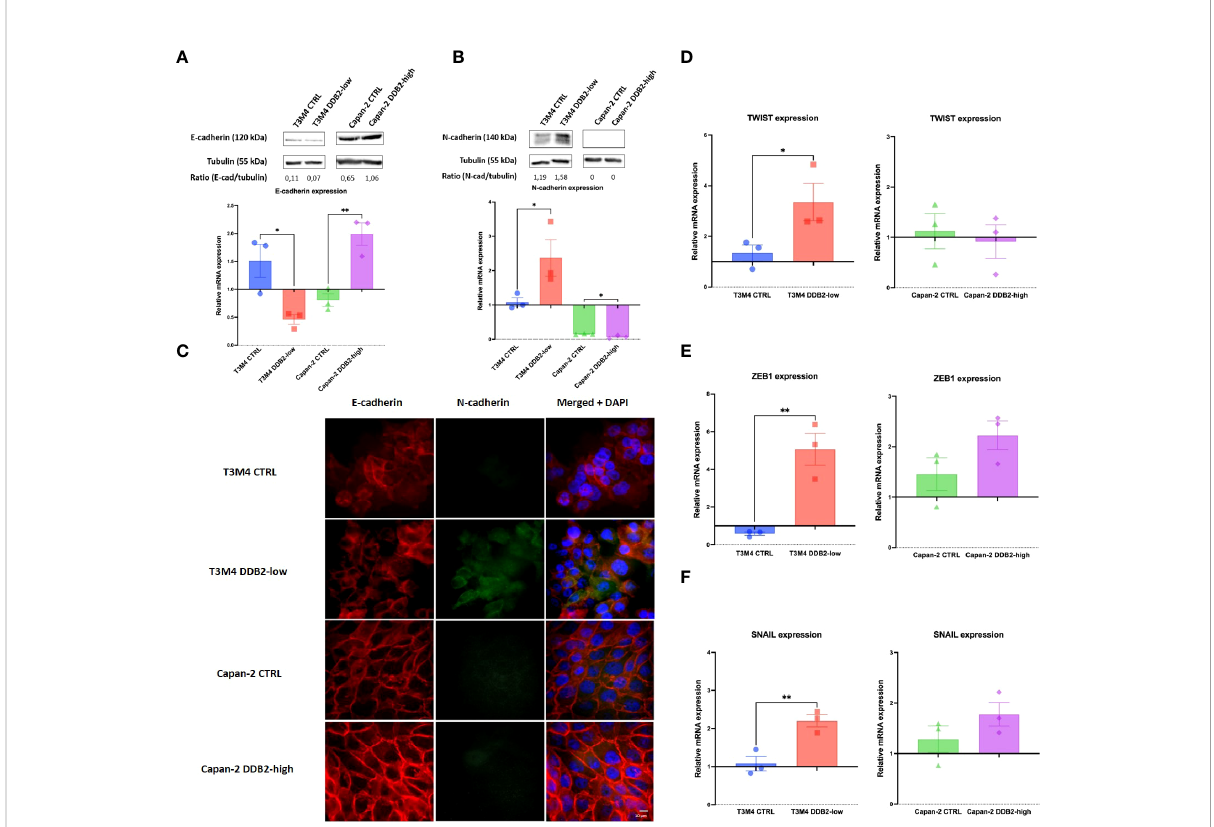
FIGURE 3 Role of the DDB2 protein in the expression of epithelial-to-mesenchymal transition (EMT) markers in T3M4 DDB2-low, T3M4 CTRL, Capan-2 DDB2-high and Capan-2 CTRL cells. Expression of E-cadherin and N-cadherin were evaluated by (A, B) Western blot and RT-qPCR and by (C) immunocytochemical analyses. The expression of three EMT transcription factors (EMT-TFs) were studied by RT-qPCR, including (D) TWIST, (E) ZEB1 and (F) SNAIL. b -actin was used as the housekeeping gene, results were normalized according to the expression levels obtained in wild type cells. Data from 3 independent experiments are expressed as mean ± SEM, *p < 0.05, **p < 0.01 (Student ’ s unpaired t